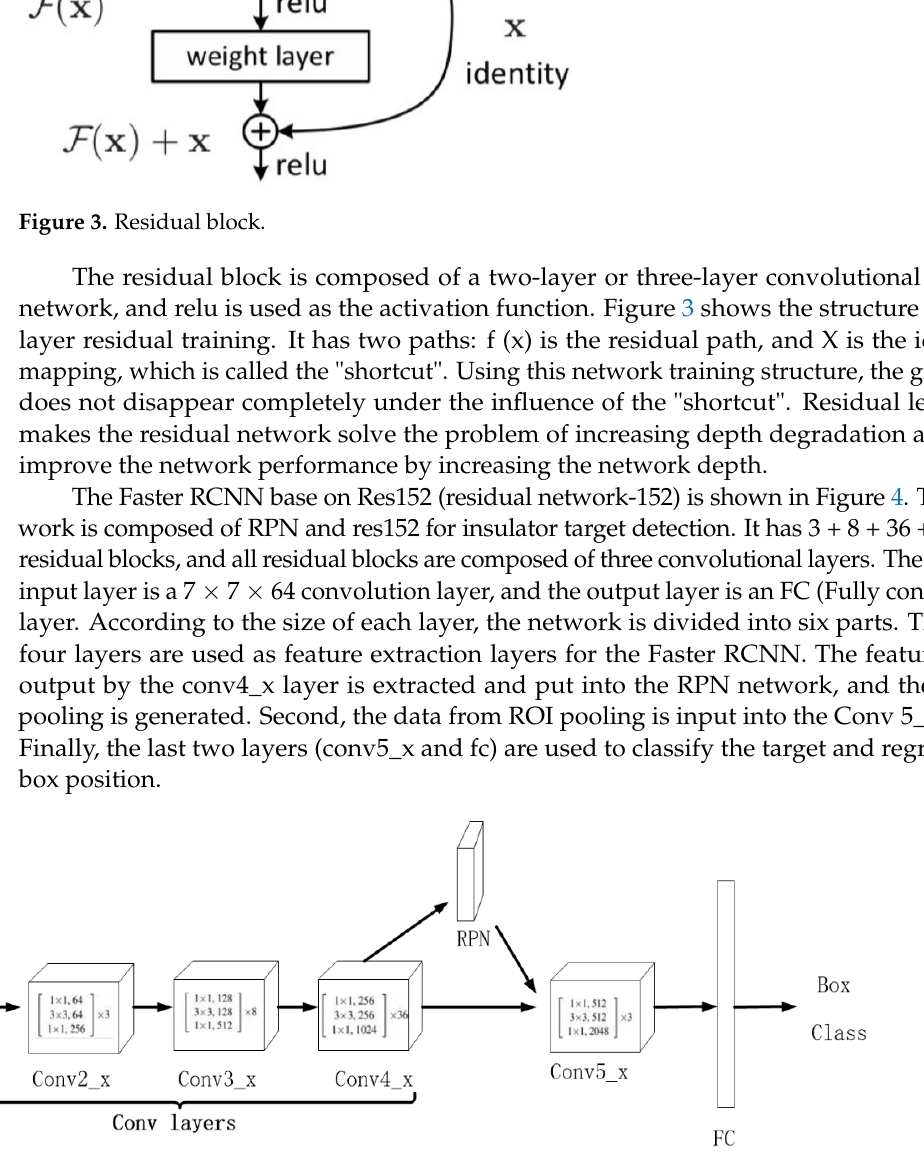
Figure 4. The structure of Faster RCNN base on Res152.